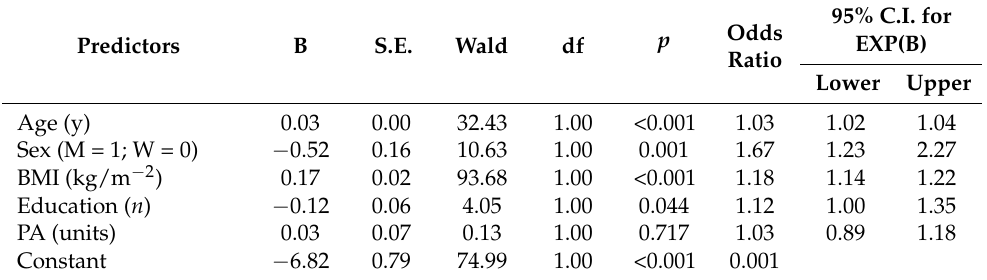
Table 3. Logistic regression predicting the likelihood of presenting metabolic